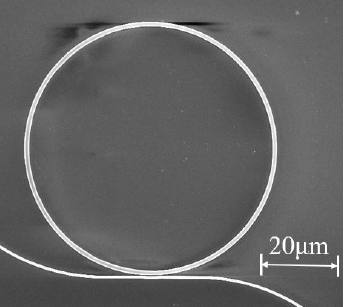
Figure 4. Top-view SEM image of the fabricated microring resonator in the 4H-SiCOI